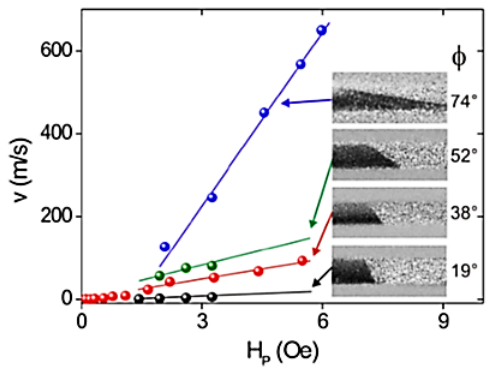
Figure 5. Dependencies of the velocity of the DW on pulsed magnetic field. Insets: domain structure images for different angles of the DW inclination. Reprinted with permission from [91].